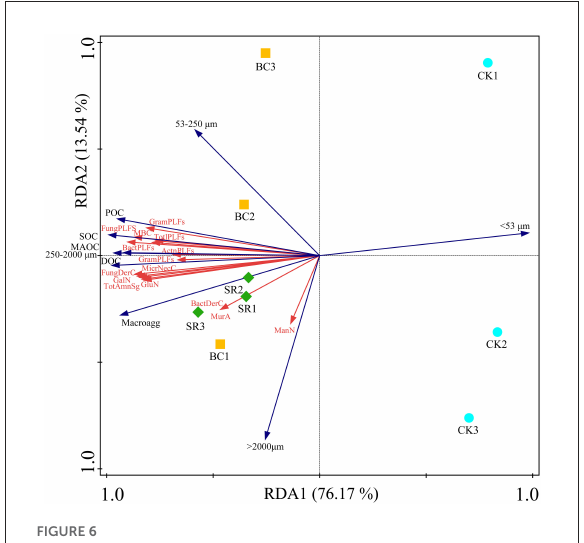
FIGURE6 Redundancy analysis (RDA) showing the effect of different environmental variables on the microbial community.